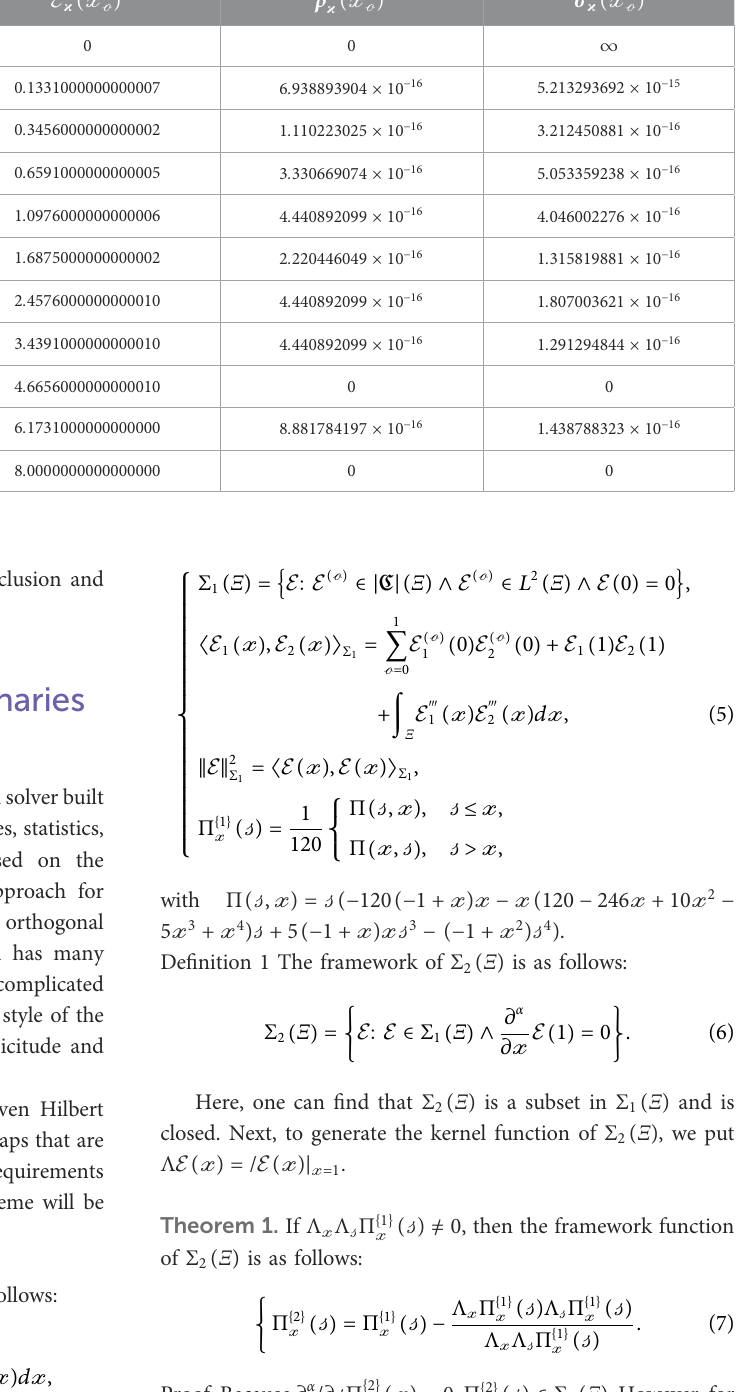
TABLE 3 Associated RKHA scores for application 3 with 8 (cid:2) 101 , when ( α , β ) (cid:2) ( 1 / 4 , 4 / 5 ) . 